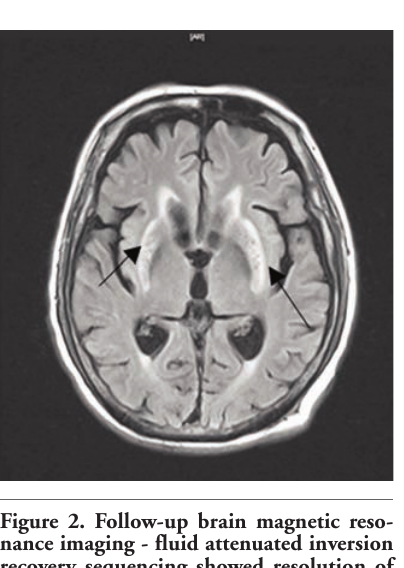
Figure 2. Follow-up brain magnetic reso- nance imaging - fluid attenuated inversion recovery sequencing showed resolution of bilateral occipital lesions with symmetrical putaminal high signal abnormalities (black